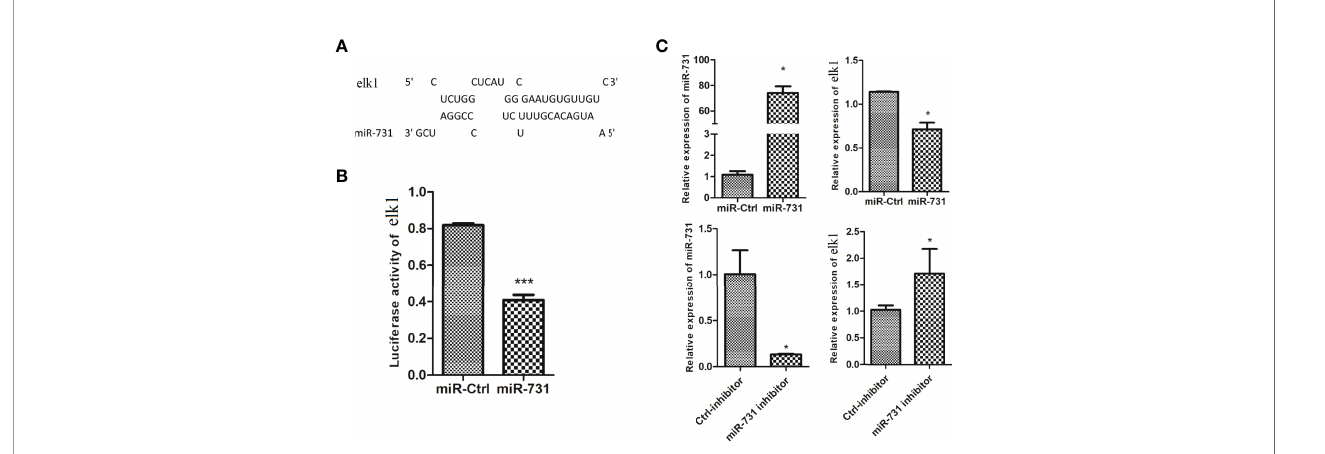
FIGURE 3 | Prediction and validation of the relationship of elk1 and miR-731. (A) Binding site of miR-731 and elk1 . (B, C) C. idella Kidney cells (CIK) were transfected with miR-731 agomir or control solution, along with the recombinant plasmids pmirGLO-elk1 for 24 h, and the luciferase activity was determined. All values represent the mean ± SD of three independent experiments. Asterisks indicate signi fi cant differences (*p < 0.05, ***p < 0.001).